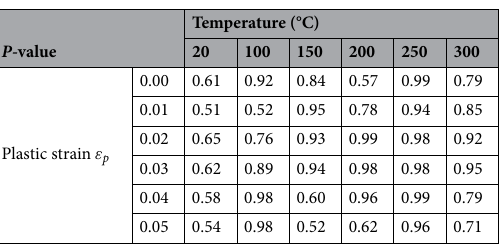
Table 2. The P -value of the Kolmogorov–Smirnov hypothesis test on the flow stress data at various temperatures and plastic strains.